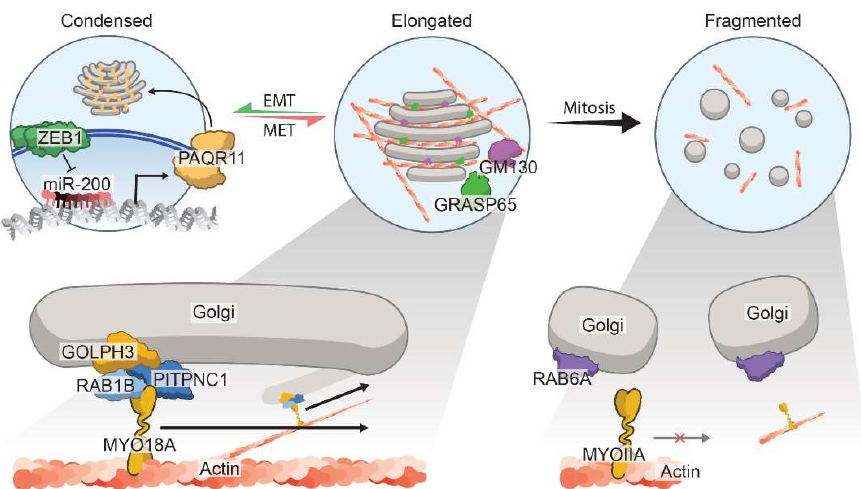
Figure 2. Regulation of Golgi morphology states in cancer. The Golgi oscillates dynamically between three main defined morphological states: the condensed (left Golgi), the elongated (middle Golgi), or the fragmented (right Golgi). Zeb1-mediated EMT orchestrates Golgi condensation by repressing the epithelial miRNA, namely, miR-200, and upregulating PAQR11. PAQR11 is a Golgi scaffold Golgi morphology is maintained via the PITPNC1–RAB1B–GOLPH3–MYO18A complex, where GOLPH3 links vesicles to myosin motors and facilitates movement along actin filaments. Addition-